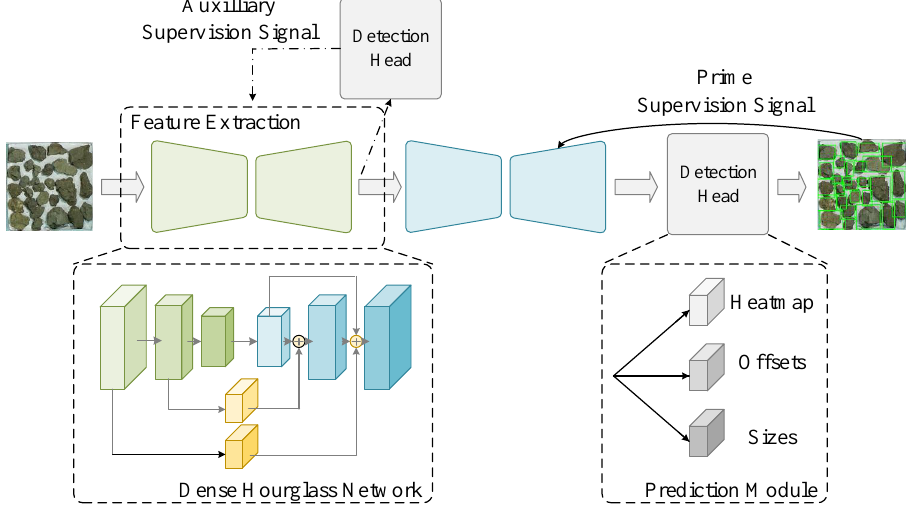
Figure 4. Illustration of deep learning-based algorithm for conglomerate and clay detection. The algorithm is divided into a feature extraction stage and a detection head